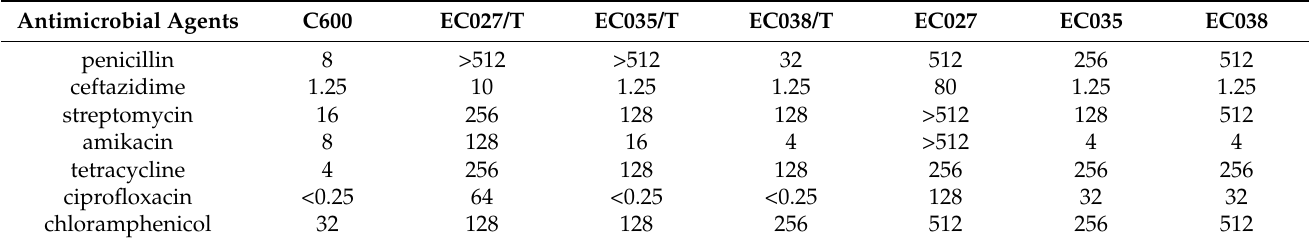
Table 6. Changes in antimicrobia sensitivity of recipient bacteria and transconjugants.